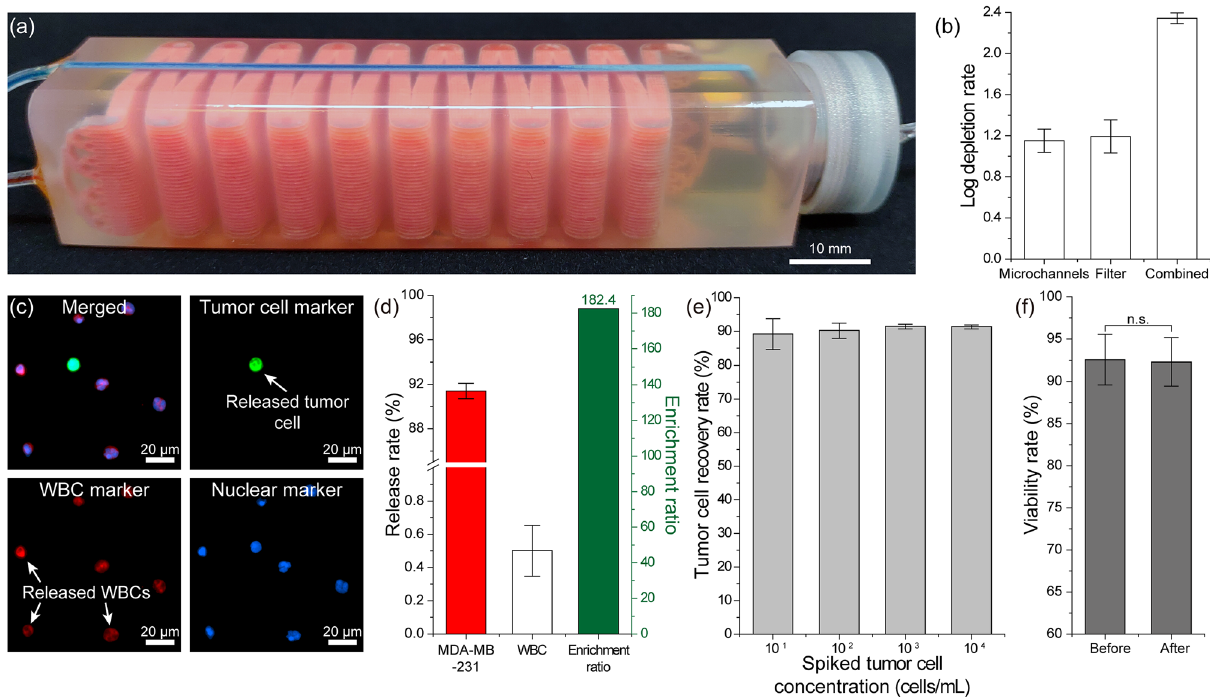
Figure 3. Characterization of the full device with simulated blood samples. ( a ) Photo of the final device with the PDMS membrane filter inserted in the filter compartment. The leukodepletion channels and the washing buffer channel were filled with a red and blue dye, respectively, to illustrate the device geometry. ( b ) Measured WBC log depletion rates in the leukodepletion channels, on the membrane filter, and the combined immunocapture rate for the whole device. ( c ) Fluorescence microscope images of the released cells in suspension. ( d ) Measured (left axis) release rates for the spiked tumor cells and WBCs, and (right axis) the enrichment ratio calculated based on these release rates. ( e ) Measured recovery rates of tumor cells spiked at different concentrations into blood samples. Tumor cell concentrations ranging from 10 1 to 10 4 cells/mL of blood were tested. A mean tumor cell recovery rate of ~ 90% was observed for all tested concentrations. The error bars represent standard deviations. ( f ) Measured tumor cell viability rates before and after processing through microfluidic device. Statistical significance was tested by performing Mann–Whitney U-tests; the difference between these two conditions was found to be not statistically